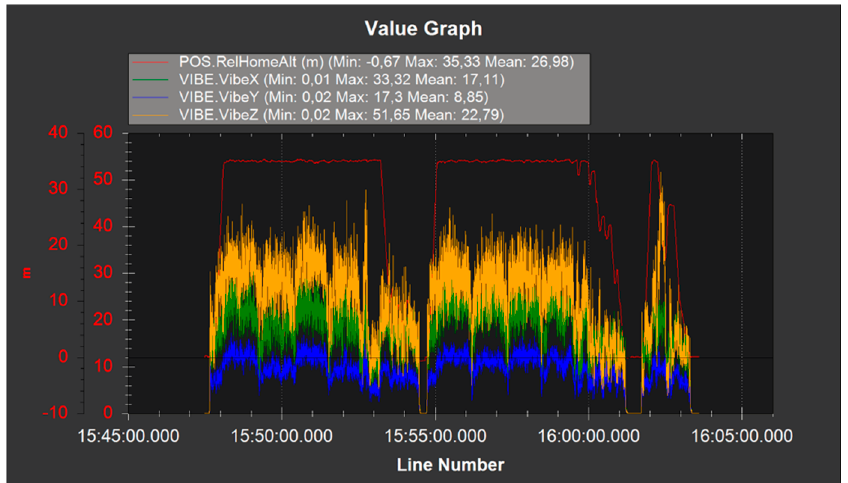
Figure 4. Vibration trends with the Smart Capsule mounted (note: comma is by used in this figure instead of dot for decimal separation).